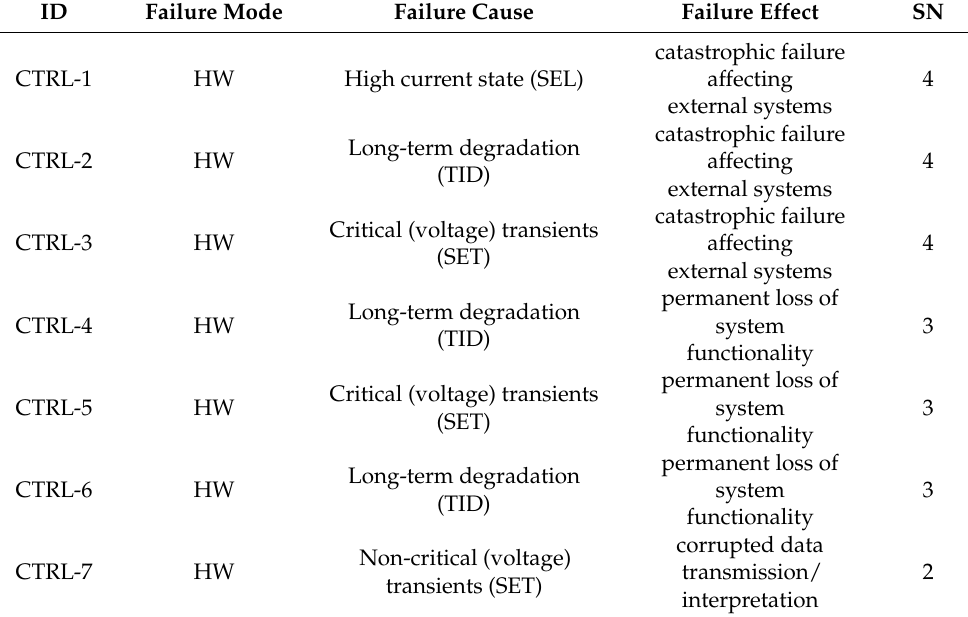
Table 4. FMECA result for the interface and control